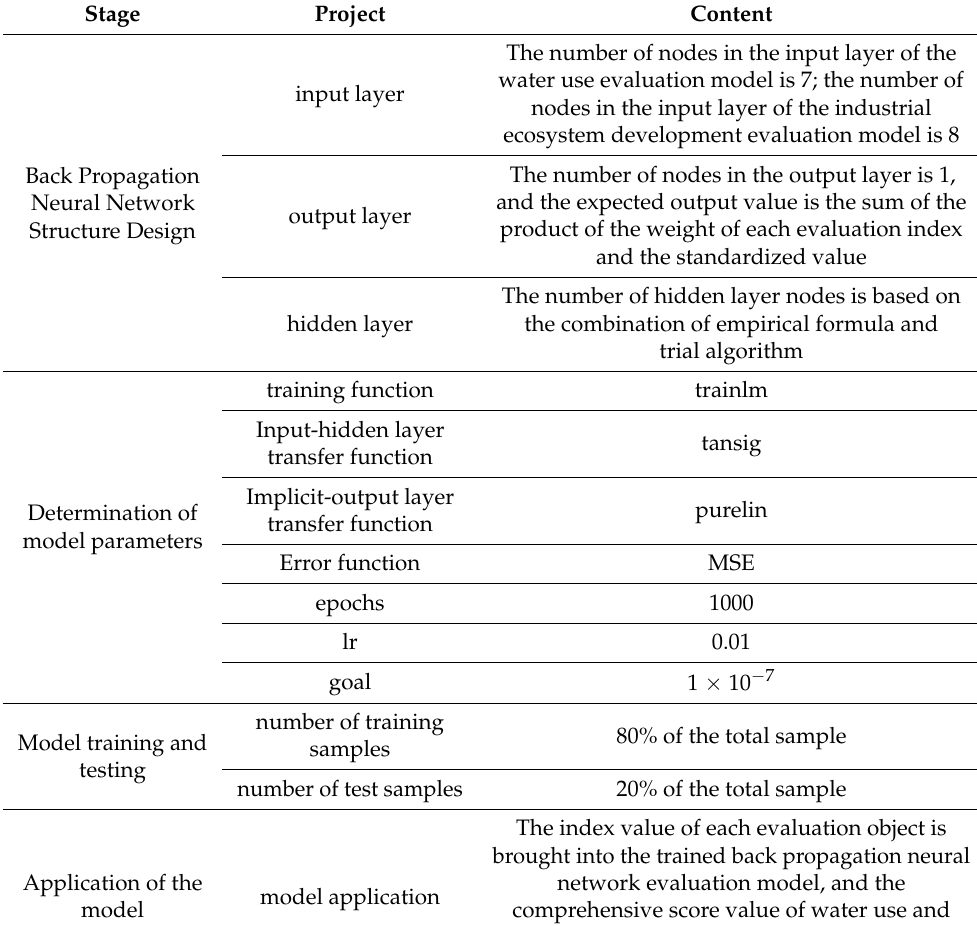
Table 2. Back propagation neural network evaluation